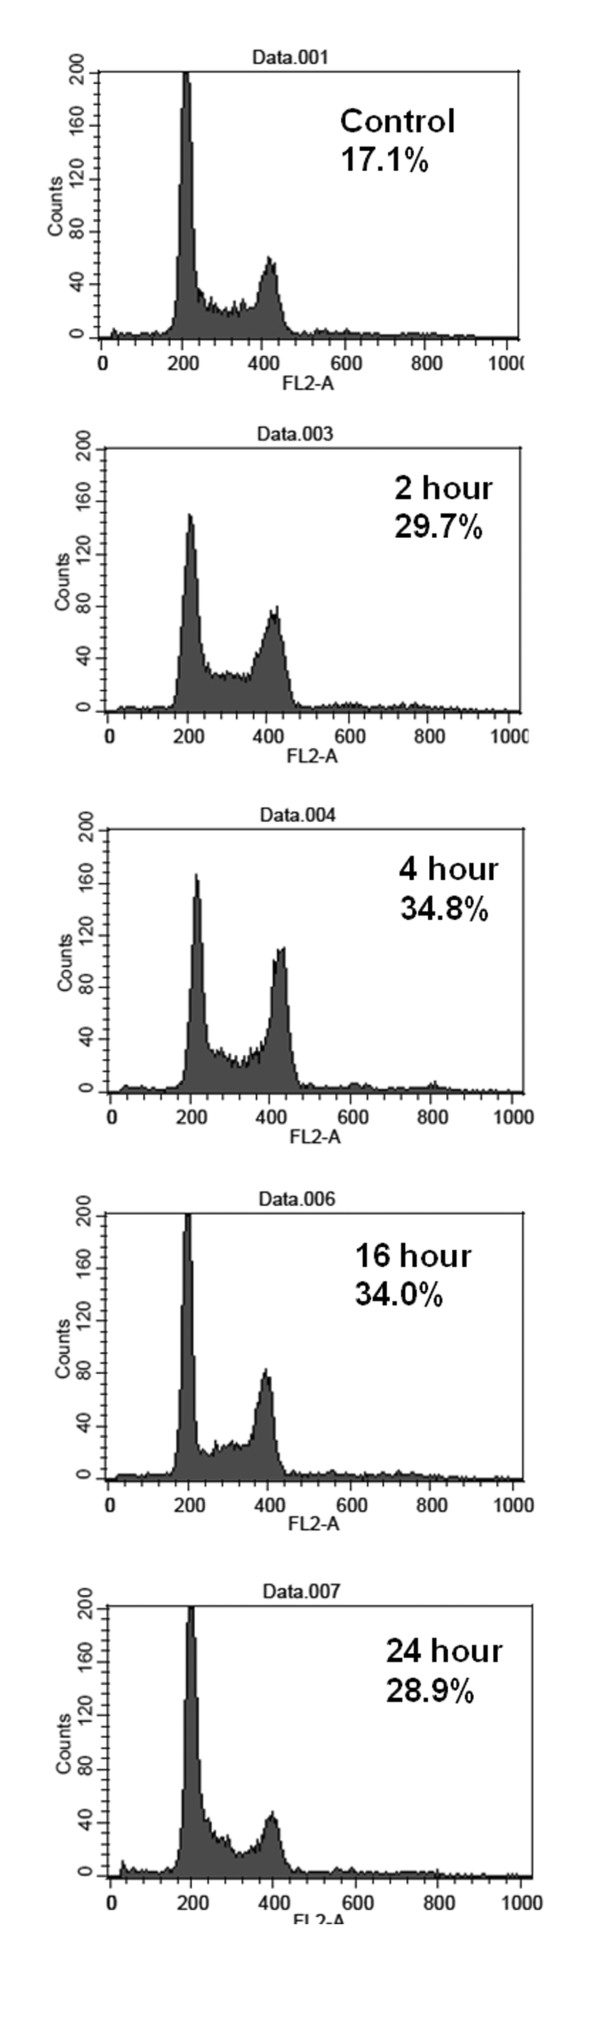
Cell cycle analysis for HA22T/VGH cells treated by costunolide. Cells were treated with costunolide (5 μM for various time periods as indicated). Representative DNA histograms were demonstrated.